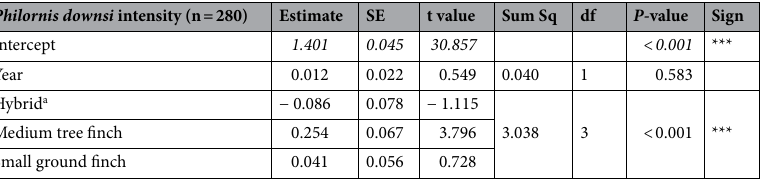
Table 1. Linear model for avian vampire fly ( Philornis downsi ) intensity in relation to year and host species collected between 2004 and 2020 from Darwin’s finch nests on Floreana. ‘Rain’ did not feature into the most parsimonious model. Avian vampire flies collected from Darwin’s finch nests over 10 years across a 17-year period on Floreana Island. a Species ‘small tree finch’ was used as a reference category. Note the response variable Philornis downsi intensity was log transformed to achieve normality and all quantitative input variables were scaled and centred. Intercept presented in italics. Sign = significance levels: ‘***’ <